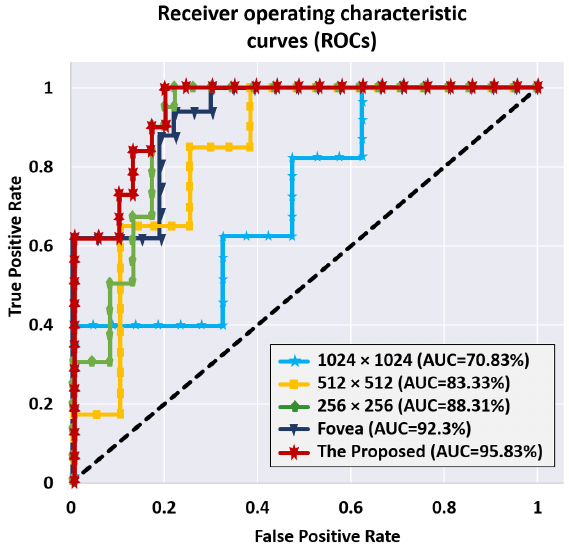
Figure 10. The ROC curves of the proposed CNN classifier for the model cross-validation in all image